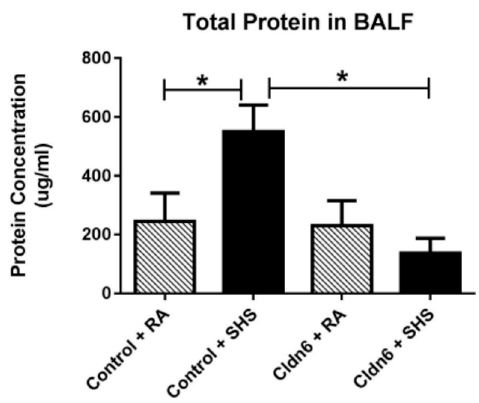
Figure 4. Total BALF protein was assayed using the BCA technique to demonstrate vascular permeability. Protein was significantly elevated in control mice following SHS exposure and there was no change in total BALF protein from Cldn6 TG mice + SHS when compared to RA groups. Data are representative of experiments involving six mouse lung samples per group and * p ≤ 0.05. Our attention next focused on the elaboration of pro-inflammatory cytokines. As expected, there was a significant increase in the expression of IL-1 mRNA and protein in whole lung homogenates from control mice after SHS exposure (Figure 5A,B). There was also a significant increase in the elaboration of IL-1 by control mice exposed to SHS into BALF (Figure 5C). Similar assessments also demonstrated that there was no increase in the expression of IL-1 message or protein when total